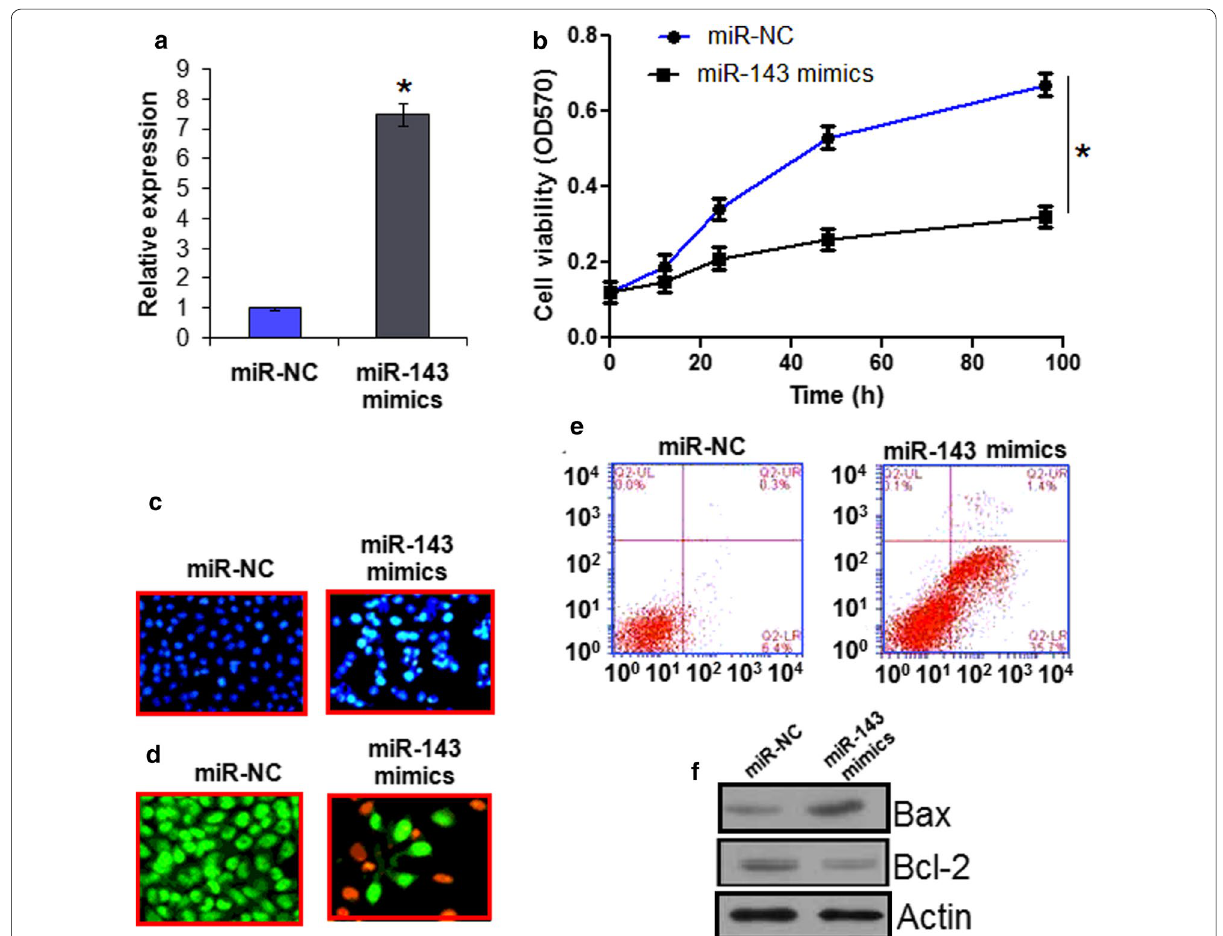
Fig. 2 a Expression of miR-143 in miR-NC and miR-143 mimics transfected CAMA-1 cells. b Cell viability of miR-NC and miR-143 mimics transfected CAMA-1 cells. c DAPI staining of miR-NC and miR-143 mimics transfected CAMA-1 cells. d AO/EB staining of miR-NC and miR-143 mimics transfected CAMA-1 cells. e Annexin V/PI staining of miR-NC and miR-143 mimics transfected CAMA-1 cells. f Western blot analysis showing the expression of Bax and Bcl-2 in miR-NC and miR-143 mimics transfected CAMA-1 cells. The experiments were performed in triplicate and expressed as mean SD (*P < ±